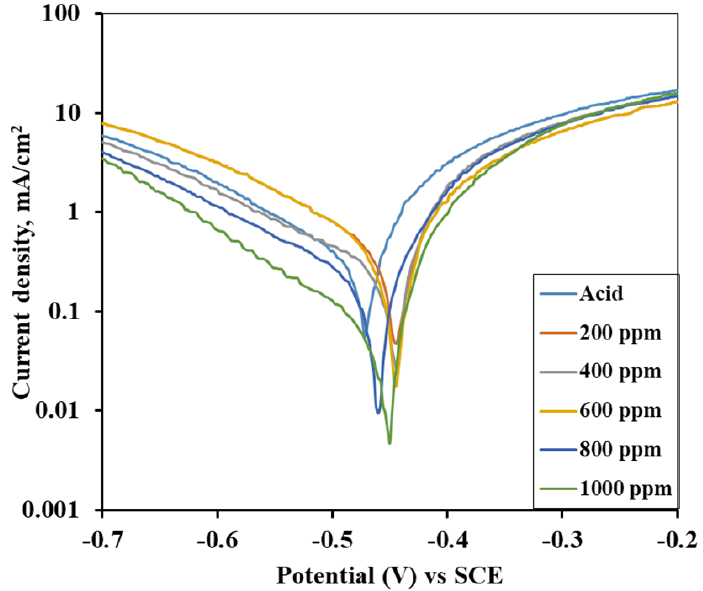
Figure 13. Potentiodynamic polarization curves for MS in 1 M H 2 SO 4 containing different concentra-